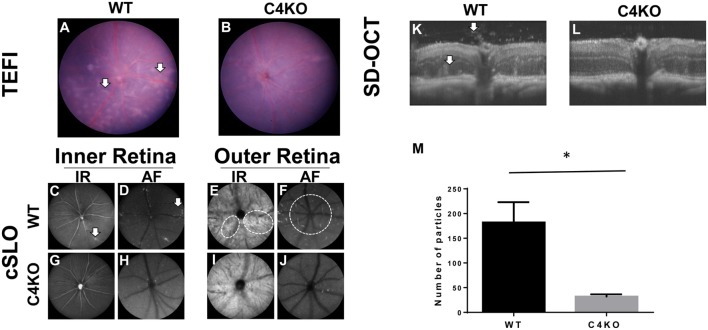
Representative pictures in wild-type (WT) and C4 KO mice with experimental autoimmune uveitis at day 15 after immunization using different ocular imaging techniques. (A,B) TEFI imaging showed linear and confluent chorioretinal lesions were common in WTs [(A), arrows] but significantly less in C4 KOs (B); (C–J) cSLO images showed hyper-reflective features to both inter (C,D,G,H) and outer layers (E,F,I,J) of the retina. Numerous foci in the inter retina can be found adjacent to retinal vessels in the WTs [(C,D), arrows]. These foci were significantly fewer in the KOs (G,H). In the outer retina, other hyper-reflective features emanating from or around the optical nerve can be seen in the WTs [(E,F), circles] but rarely found in the KOs (I,J); (K,L) SD-OCT images revealed more reflective foci and retinal infoldings in the WTs [(K), arrows] than with those in the KOs (L). A summary of the numbers of hyper-reflective foci in vitreous cavities was presented in panel (M).